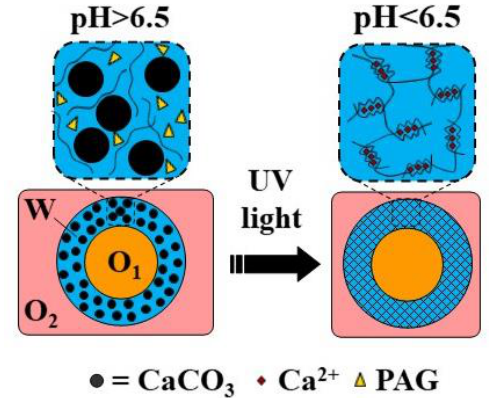
Figure 30. Formation of alginate capsules with an oil core through the internal gelation of the middle phase of O/W/O emulsion droplets containing CaCO 3 and a photo-acid generator (PAG). The crosslinking is triggered by UV irradiation, which releases acid from PAG and dissolves CaCO 3